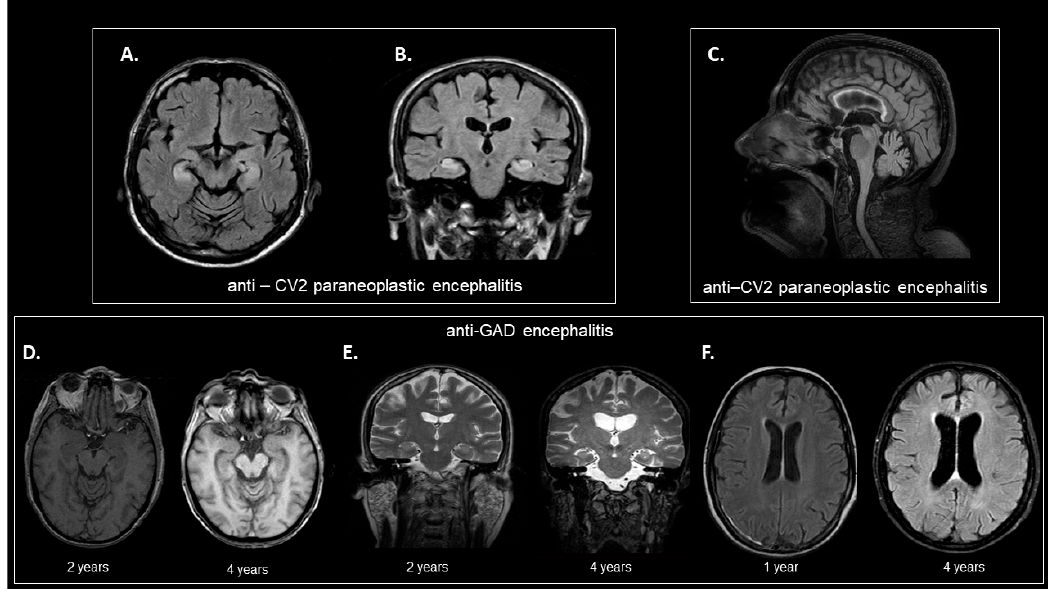
Figure 2. Representative MRI findings of our study cohort. ( A , B ) Brain MRI from a 72-year-old male patient with a diagnosis of anti-CV2 paraneoplastic encephalitis. Axial ( D ) and coronal ( E ) T2- weighted FLAIR images (at 1.5T). T2-weighted FLAIR signal hyperintensities can be seen in the hippocampi and amygdalas bilaterally. ( C ) Example of brain MRI from an 82-year-old female patient with a diagnosis of anti-CV2 paraneoplastic encephalitis. Sagittal FLAIR sequence (at 3T) showing signs of cerebellar vermal atrophy. The atrophy of the anterior lobe of cerebellar vermis (with dilatation of the primary fissure) is disproportionate to posterior lobe atrophy of cerebellar vermis and